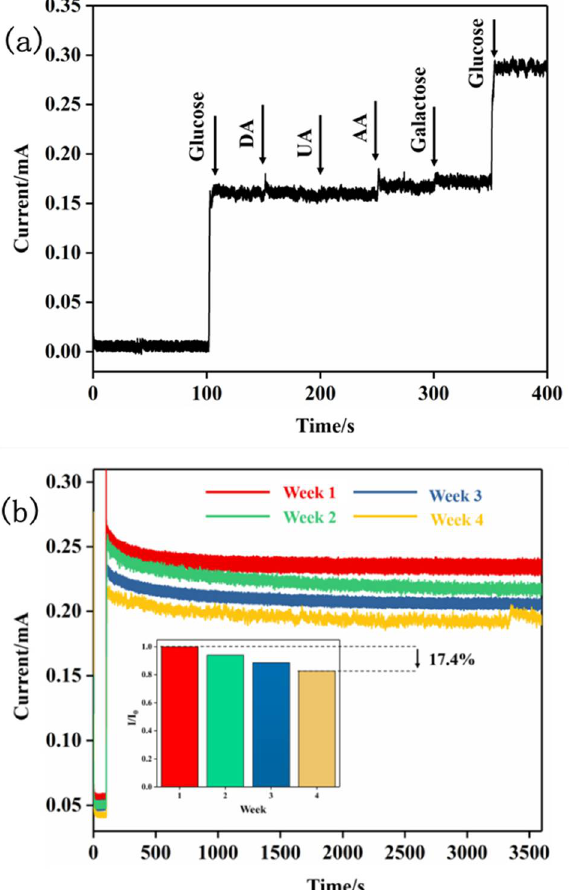
Figure 9. ( a ) Anti-interference test results of Ni-DLC/TNT composite electrode; ( b ) Stability test of TNT-Ni/DLC composite electrode. The i-t curve in 1 mM glucose solution was measured once a week. The illustration shows the results of each test relative to the first test.